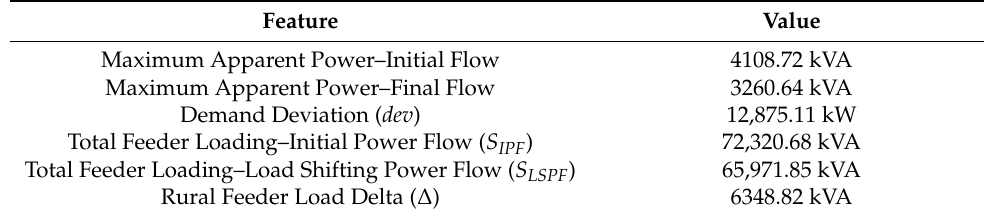
Table 5. Summary on the application of the load shifting strategy on Rural Feeder